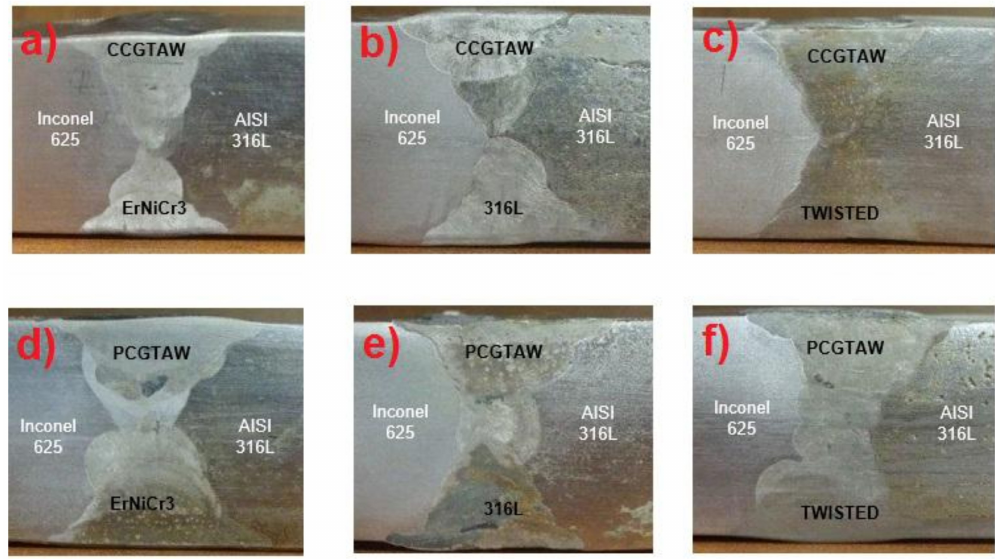
Figure 3. Cross-section macrographs of the CCGTA ( a – c ) and PCGTA ( d – f ) weldments of Inconel 625 and AISI 316